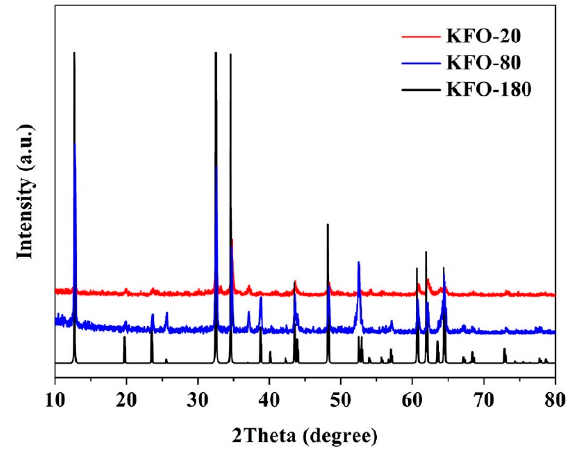
Figure 2. Powder XRD patterns of KFO-20, KFO-80, and KFO-180.